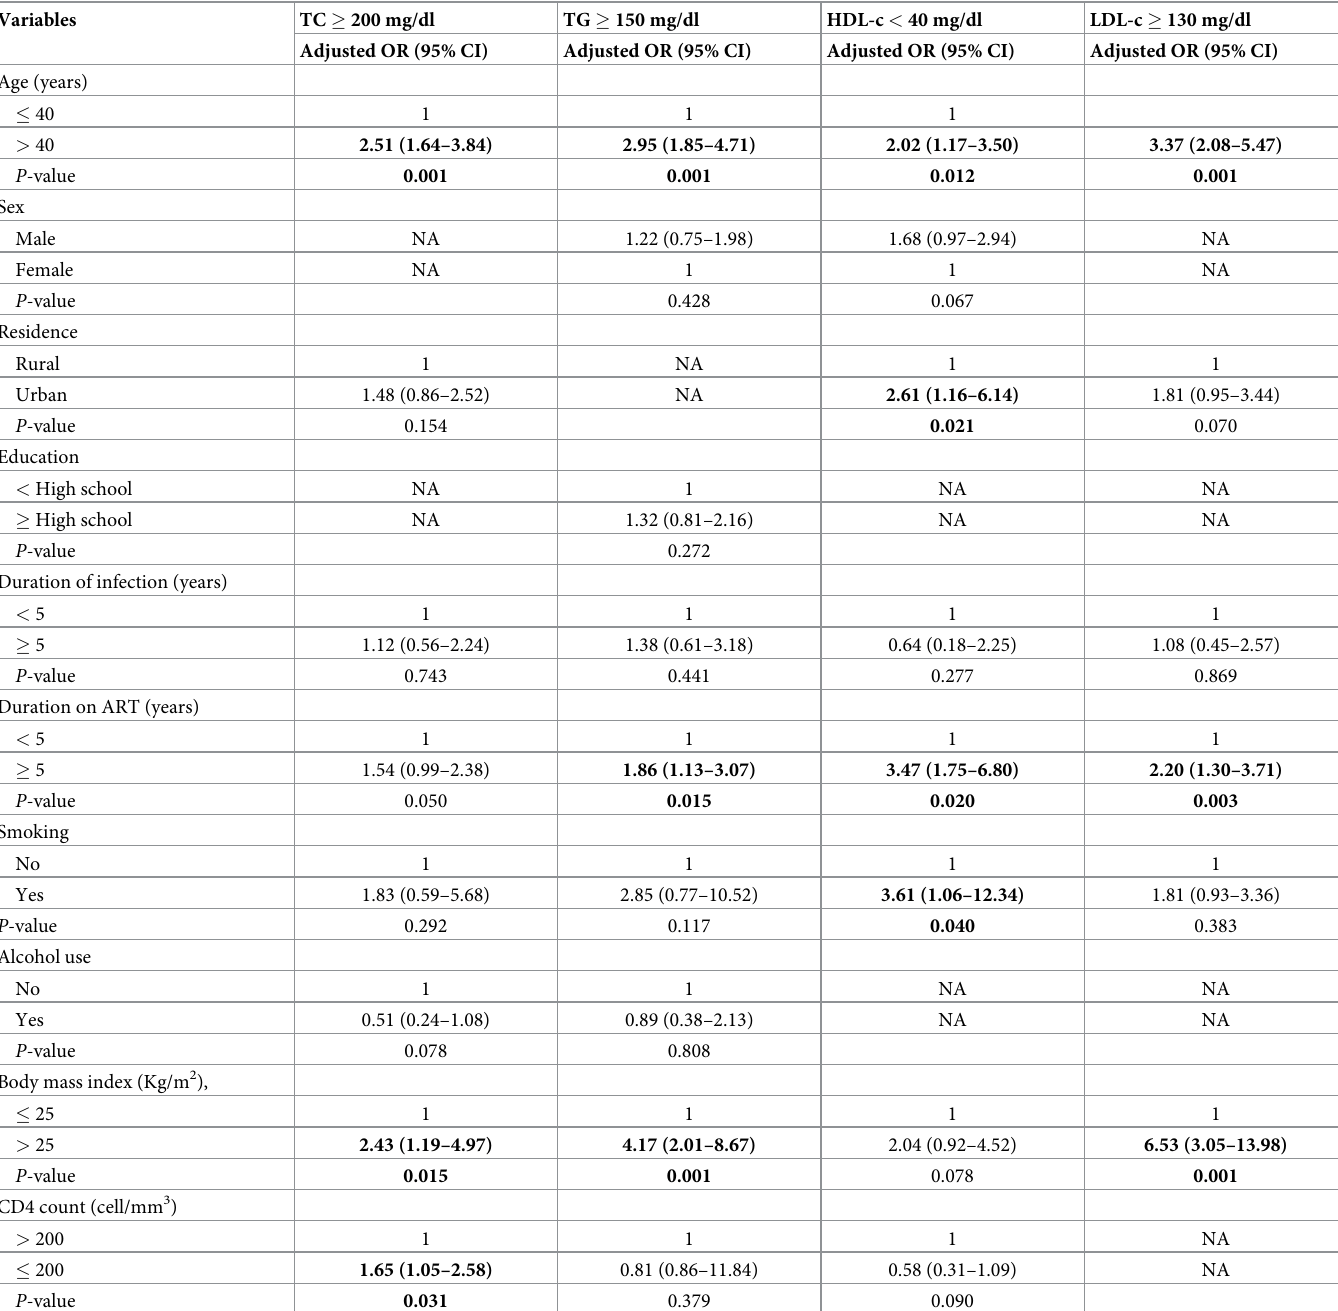
Table 4. Factors associated with abnormal lipid levels among HIV-infected patients receiving ART in North Shewa,